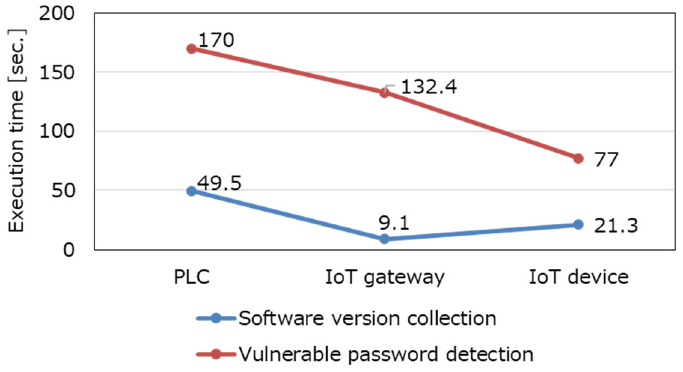
Figure 9. Performance test (execution time).